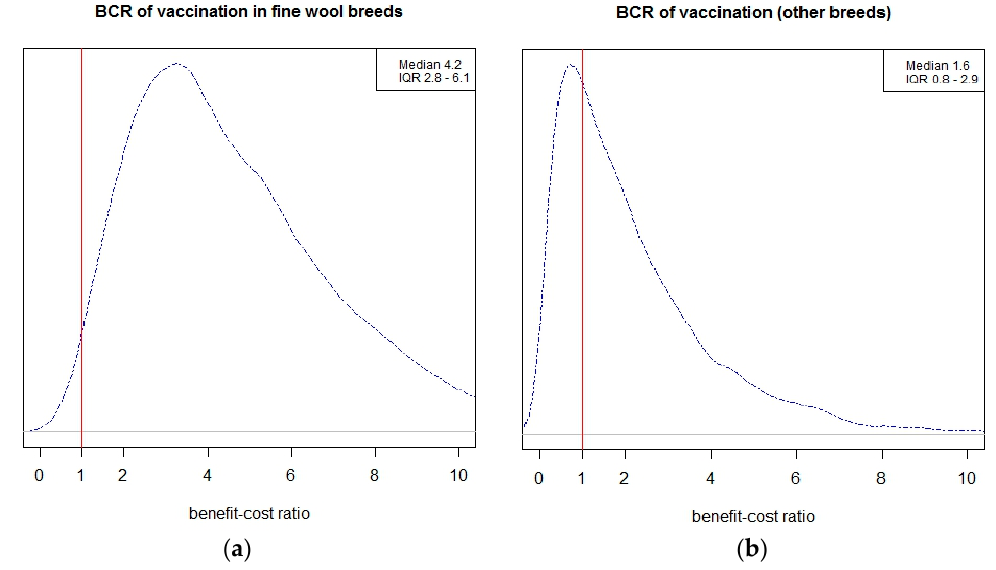
Figure 3. Density plots of benefit-cost ratio in fine-wool ( a ) and other breeds ( b ) and interquartile range (IQR, 25th–75th percentiles). The vertical line represents the breakeven point where benefit-cost ratio is one.